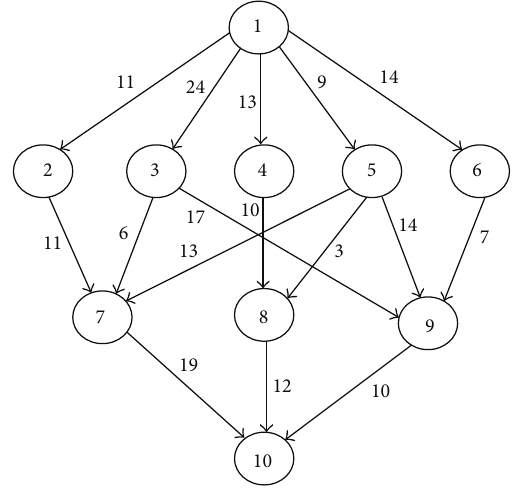
Figure 2: A sample task graph with 10 tasks. Table 1: Computation costs.